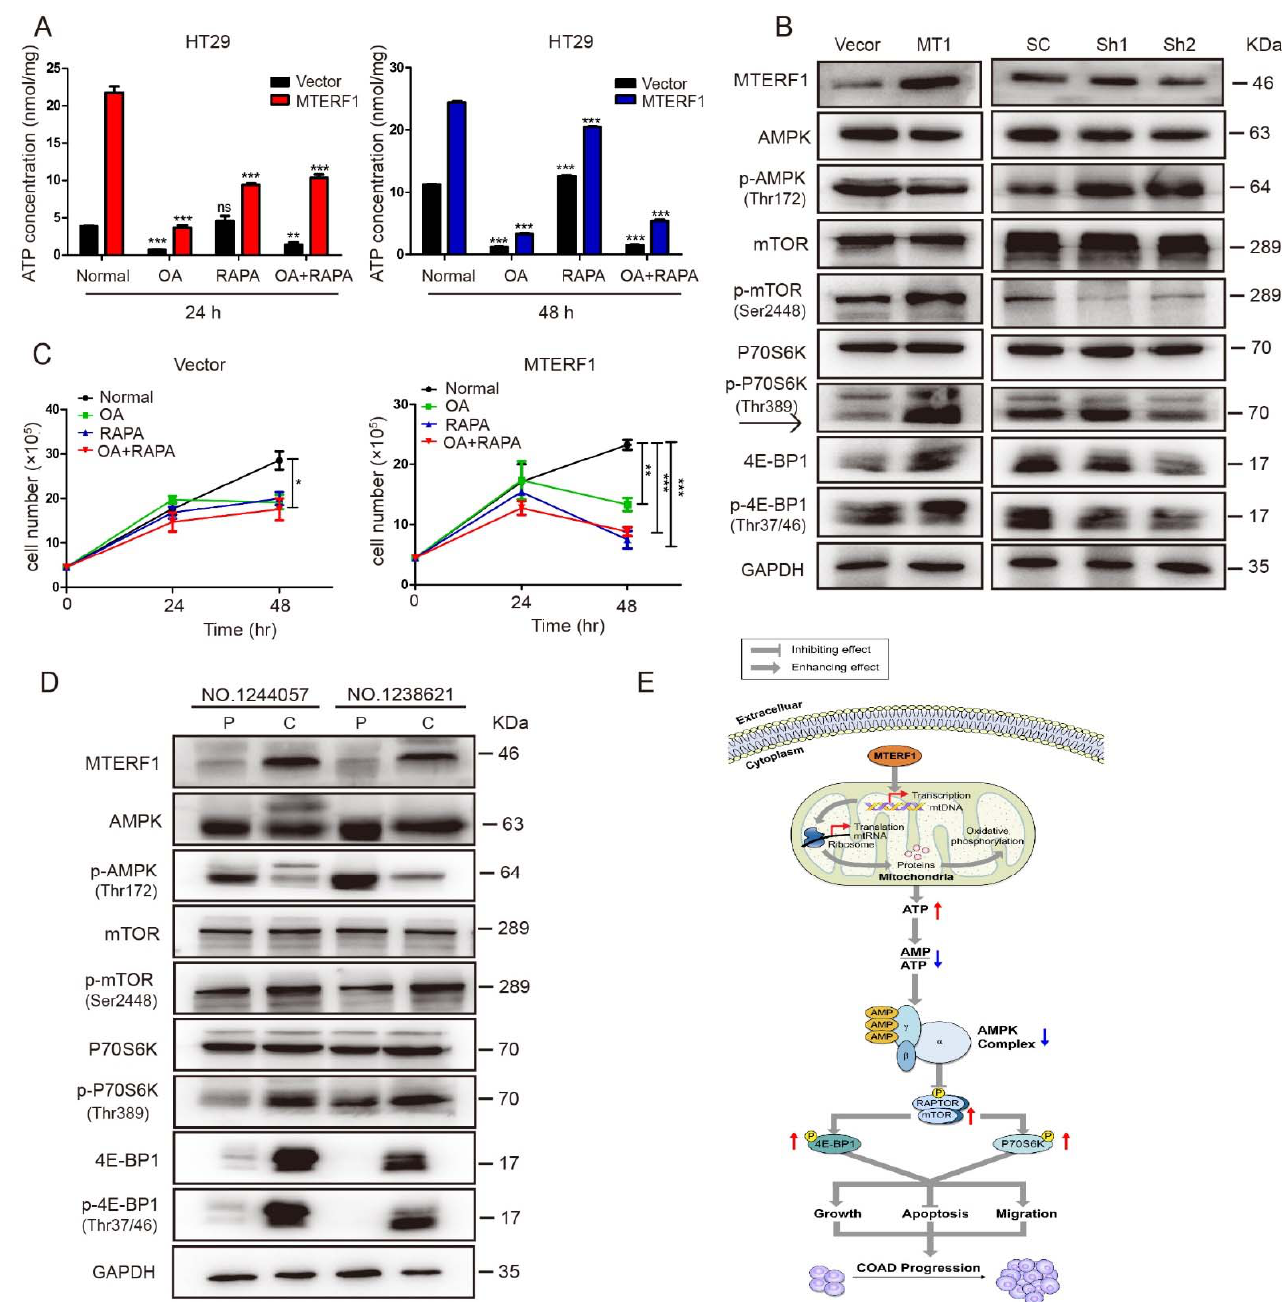
Figure 7. MTERF1 regulates the p ‐ AMPK ‐ mTOR signaling pathway in xenograft tumor tissue and human clinical samples. ( A , B ) HT29 cells with MTERF1 overexpression were treated with 5 μ M oligomycin A (OA) and 300 nM rapamycin (RAPA) to detect the effect on ATP levels ( A ) and cell proliferation ( B ). ( C , D ) Protein expression levels of AMPK/mTOR signaling pathway ‐ related pro ‐ teins in xenograft tumor tissue ( C ) and human clinical samples ( D ). ( E ) Working model for MTERF1. As proposed in CRC cells, MTERF1 increased mitochondrial replication, transcription, and protein synthesis, which enhanced mitochondrial OXPHOS and ATP levels, thus promoting mTOR phos ‐ phorylation levels and finally promoting the occurrence and development of CRC cells. NS repre ‐ sents no significant difference. * p < 0.05, ** p < 0.01, *** p < 0.001 , two ‐ tailed Stu ‐ dent’s t ‐ test. Data represent the mean ± SD from at least three independent biological replicates.